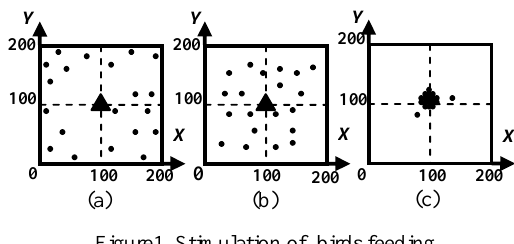
Figure1. Stimulation of birds feeding (a) initial distribution of birds (b) distribution of birds after 20 iteration (c) distribution of birds after 100 iteration At the beginning of PSO procedure, a swarm of particle (random solution) are initialized, and the optimal solutions will be found through evolutionary computation (iterative computation). Each particle will update themselves through tracing two extremum. One extremum, called individual extremum p Best , is the optimal position found by the particle itself, the other, called globe extremum g Best , is the optimal position found by the whole particle swarm. The mathematical description of PSO is flowed. Suppose in